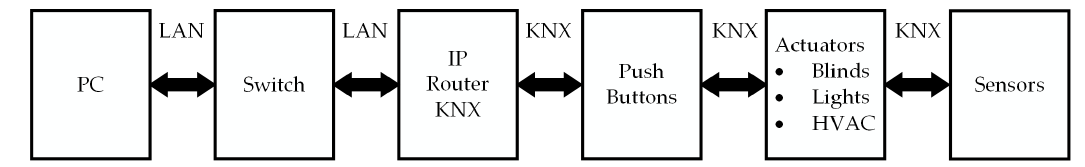
Figure 1. Block diagram of PC and KNX technology connection using an IP router.